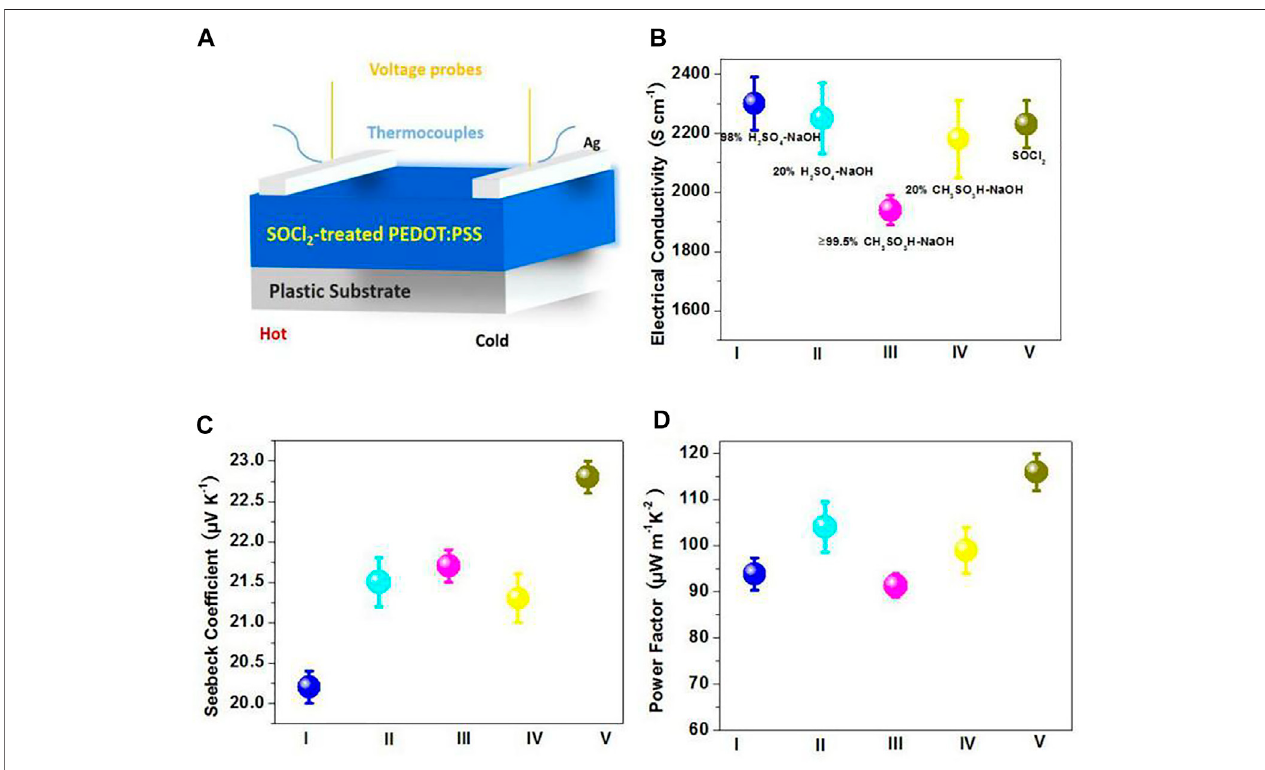
FIGURE 6 | (A) Schematic diagram of fl exible TEs. (B – D) Temperature-dependent electrical conductivity (B) , Seebeck coef fi cient (C) , and power factor (D) of the TEs. I : 98 wt.% H 2 SO 4 (RT)-NaOH treatments, II : 20 wt.% H 2 SO 4 (140 ° C)-NaOH treatments, III : ≥ 99.5 wt.% CH 3 SO 3 H (RT)-NaOH treatments, IV : 20 wt.% CH 3 SO 3 H (140 ° C)-NaOH treatments, and V : SOCl 2